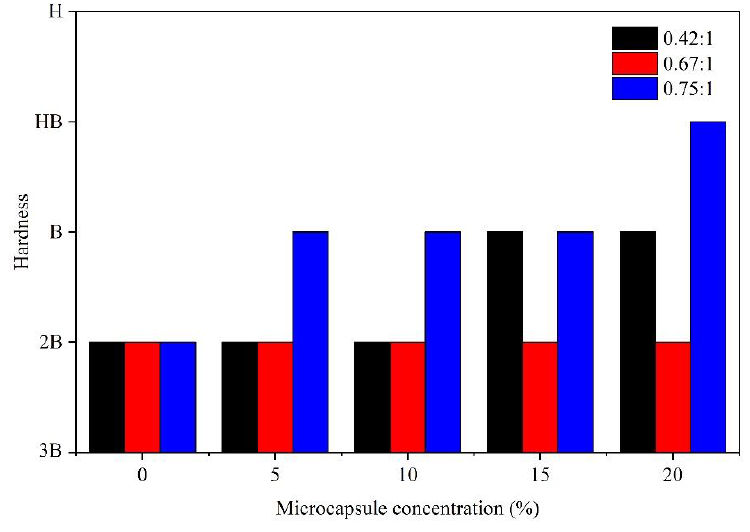
Figure 4. E ff ect of microcapsule concentration (0.42:1, 0.67:1, and 0.75:1 core-wall ratios) on hardness.